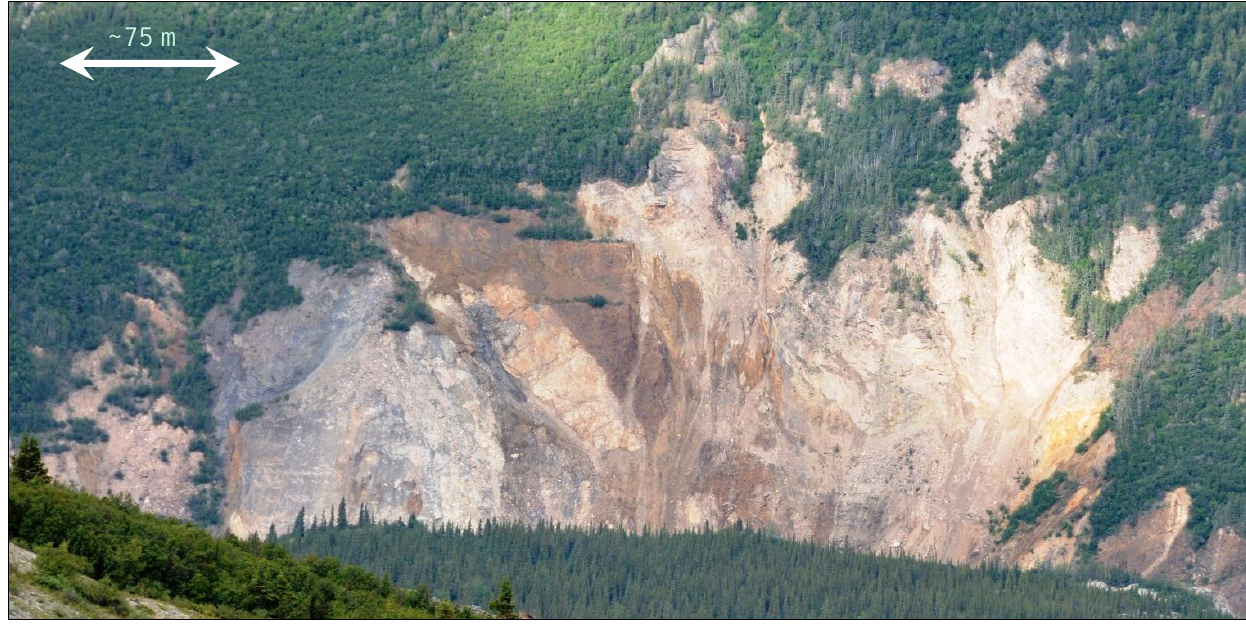
Figure 17. Photograph of Site C . This photograph captures approximately 0.5 km of the slope along the highway . The highway and river are obscured by the lower trees.